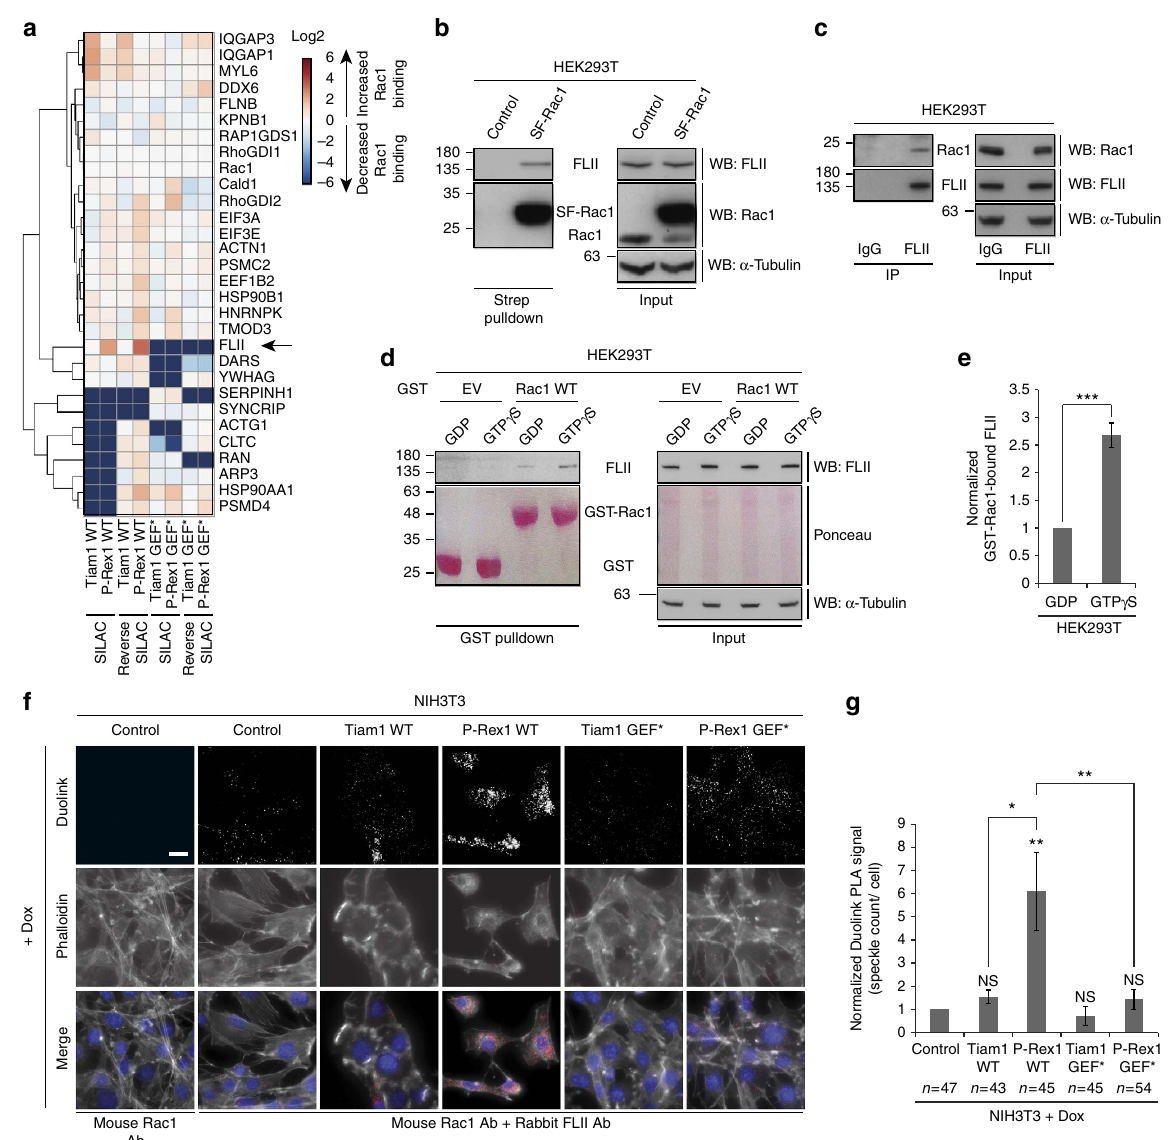
Figure 3 | FLII is a novel P-Rex1-enriched Rac1 interactor that binds preferentially to active Rac1. ( a ) Heat map of indicated SILAC identified Rac1 interactors classified under one of the following Ingenuity integrated pathway analysis (IPA) functional groups: cell movement, cell morphology, cell signalling, cell-to-cell signalling and interaction, as well as cell assembly and organization. The heat map represents the Log2 of SILAC protein ratios relative to control cells expressing SF-Rac1 alone from a representative SILAC and reverse SILAC screen. ( b ) Streptavidin ( Strep ) pulldown from HEK293T cells expressing SF-Rac1. Co-precipitated endogenous FLII was detected by western blot analysis. ( c ) Endogenous FLII immunoprecipitation (IP) from HEK293T cells. Co-precipitated endogenous Rac1 was detected by western blot analysis. In b , c , a -Tubulin was used as a loading control. Representative western blots from three independent experiments. ( d ) GST pulldown using purified GST (EV) or GST-tagged Rac1 WT (Rac1 WT) loaded with GDP or GTP g S and incubated with HEK293T lysates. Co-precipitated endogenous FLII was detected by western blot analysis. a -Tubulin and ponceau staining were used as loading controls. ( e ) Quantification of endogenous GST-Rac1-bound FLII in HEK293Tcells described in d normalized to GDP-loaded GST-Rac1 WT ± s.e.m. from three independent experiments. Student’s t -test was used to assess significance as indicated on graph. *** ¼ P r 0.001. ( f ) Representative immunofluorescence images of NIH3T3 cells fixed in 4% formaldehyde and subjected to the Duolink in situ PLA assay following treatment with 1 m gml (cid:2) 1 doxycycline ( þ dox) for 24h to induce expression of indicated GEF constructs. Phalloidin and DAPI were used to visualize the actin cytoskeleton and nuclei, respectively. Scale bar, 20 m m. ( g ) Quantification of average Duolink PLA signal from indicated number of NIH3T3 cells described in f ± s.e.m. Student’s t -test was performed to determine statistical significance and P values are shown on graph. P values indicated above each bar are relative to control cells. NS, non-significant; * ¼ P r 0.05; ** ¼ P r